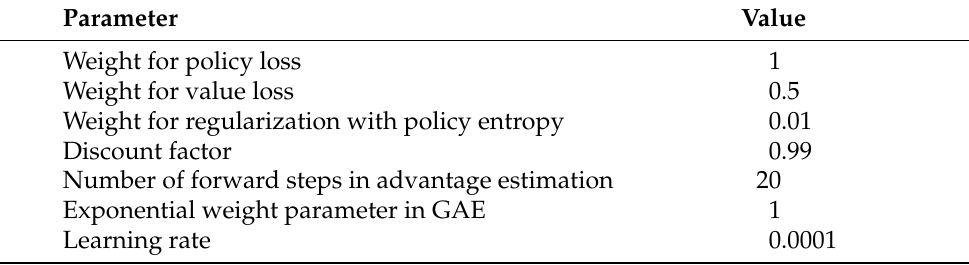
Table 2. Hyperparameters in deep reinforcement